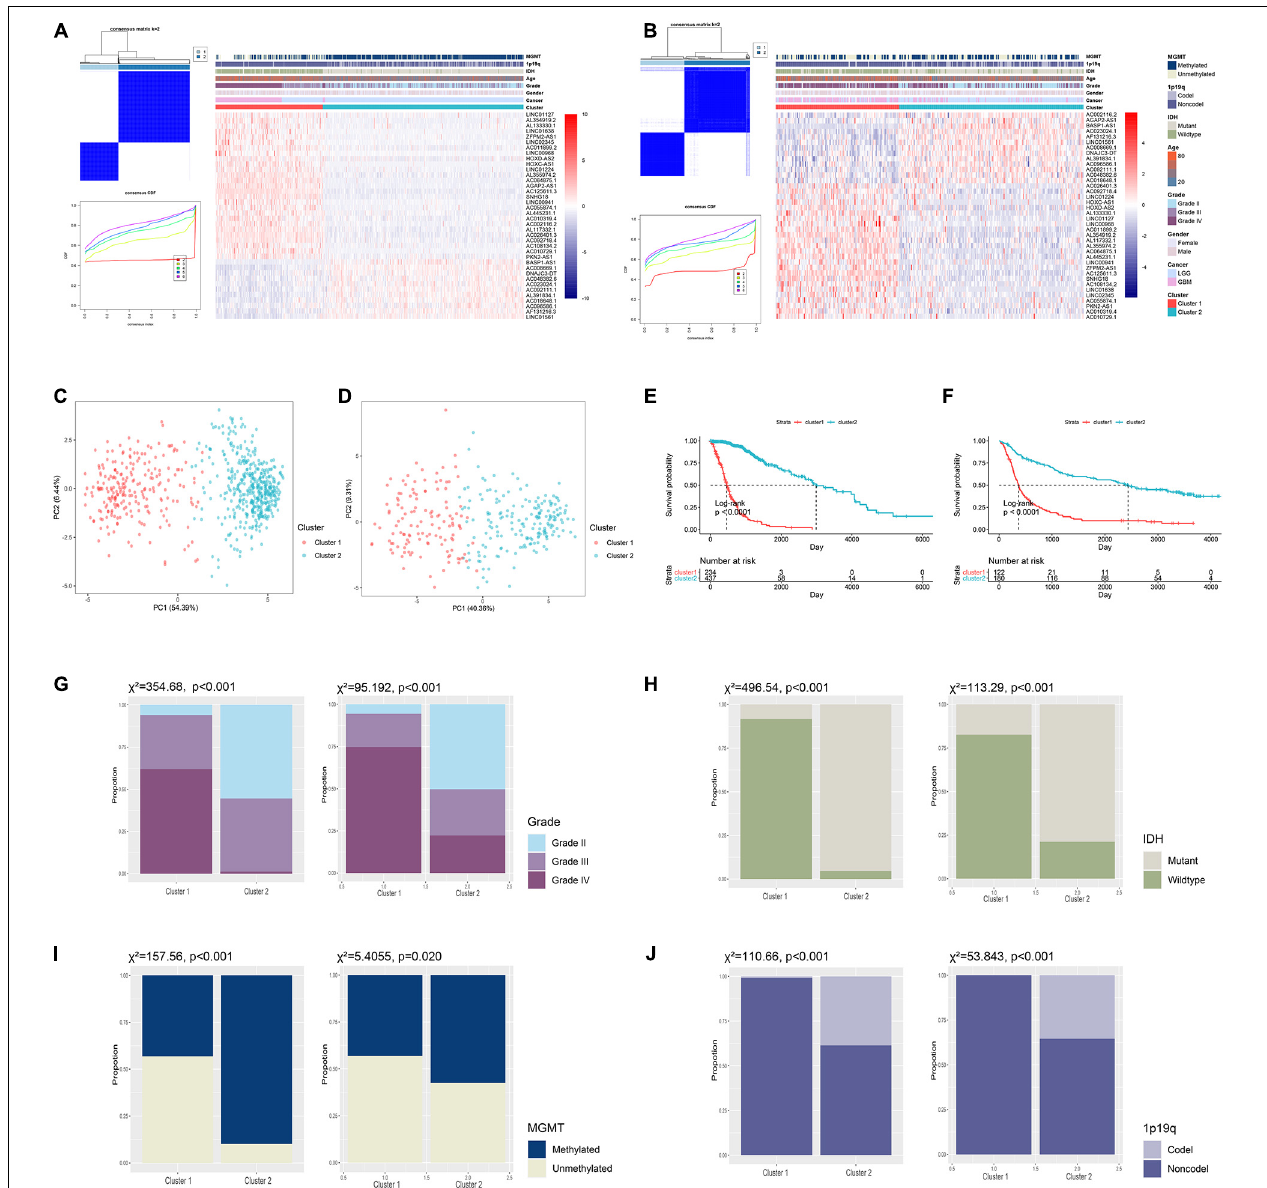
FIGURE 2 | Unsupervised clustering of diffuse gliomas based on expression of ARLs. (A,B) Consensus clustering classified diffuse gliomas into two clusters in TCGA (A) and CGGA (B) datasets. (C,D) Principal component analysis of two clusters in TCGA (C) and CGGA (D) datasets. (E,F) Kaplan-Meier analysis of glioma patients in two clusters in TCGA (E) and CGGA (F) datasets. (G–J) The proportion of different grades (G) , IDH1 status (H) , MGMT status (I) , and 1p19q status (J) of gliomas in cluster 1 and cluster 2 in TCGA and CGGA datasets.